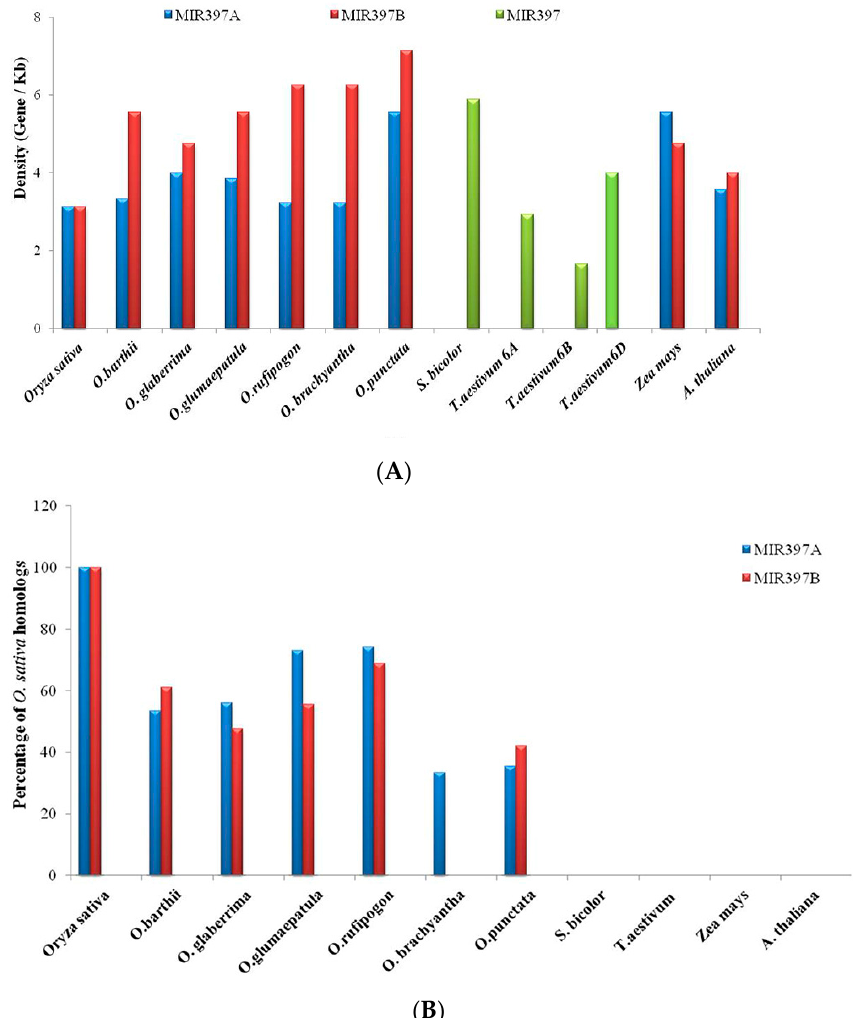
Figure 3. Graphical representation of ( A ) percentage of O. sativa homologs in 100 kb genomic segments harboring MIR397A/B conserved among O. sativa , other poaceae members, and Arabidopsis ; ( B ) density of genes present in 100 kb genomic segments harboring MIR397A/B across different poaceae members and Arabidopsis .